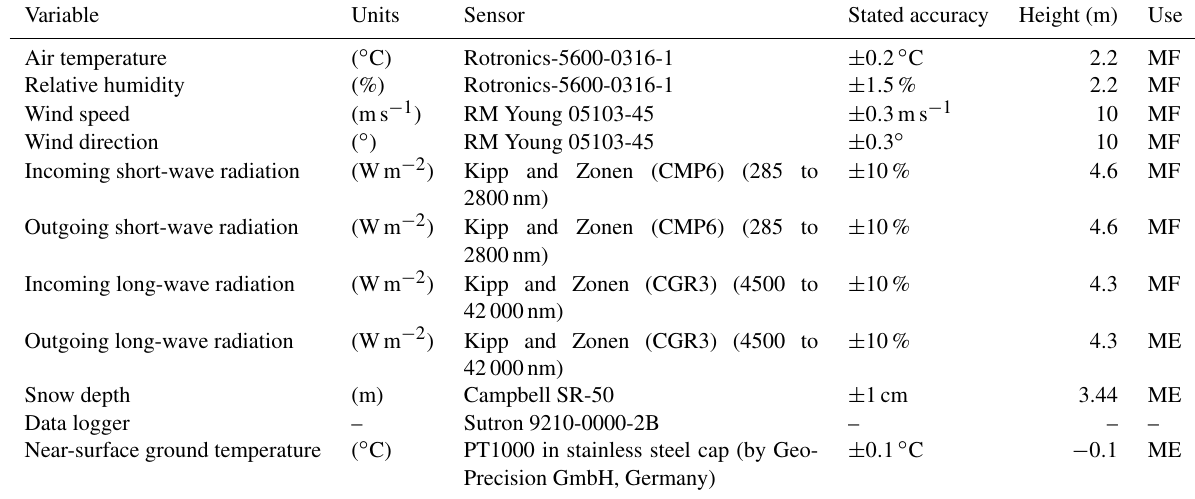
Table 1. Technical parameters of different sensors at South Pullu (4727ma.s.l.) in the upper Ganglass catchment, Leh. (MF: model forcing, ME: model